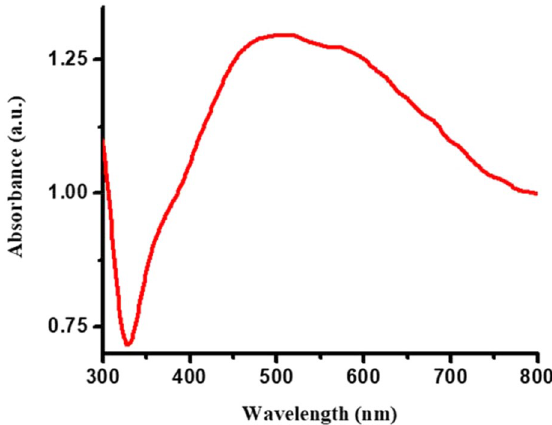
Figure 5. UV–Vis spectrum of Ag nanoparticle.